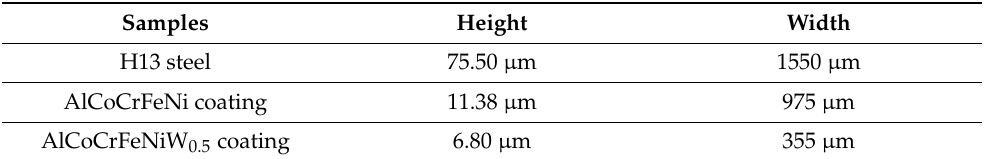
Figure 7. Three-dimensional morphologies and height analysis of the wear scars of sam- ples after 800 ◦ C/60 min friction and wear tests: ( a , b ) H13 steel; ( c , d ) AlCoCrFeNi coating; ( e , f ) AlCoCrFeNiW 0.5 coating. Table 3. Wear scars height and width of H13 steel, AlCoCrFeNi and AlCoCrFeNiW 0.5 coatings after 800 ◦ C/60 min high temperature friction and wear